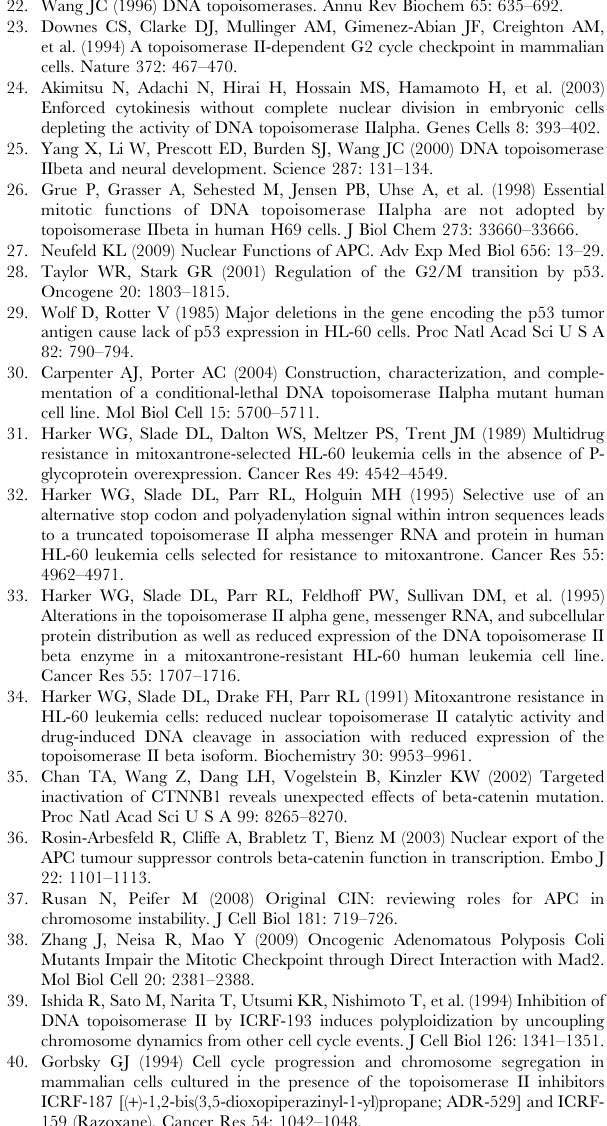
Table S4 Cell cycle distribution of SW480 cells expressing GFP, M2-APC, or M3-APC. Cell cycle distributions of GFP, M2-APC, and M3-APC expressing cells at 48 hours post-transfection. For each transfection, 10,000 GFP-positive cells were analyzed. Table shows the average from three independent experiments. For aneupoid cells, p values for M2-APC is 0.16, and for M3-APC is 0.09.